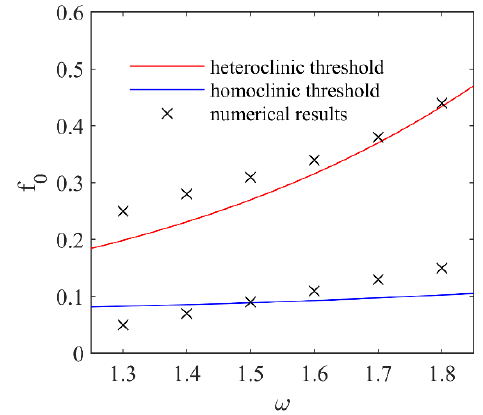
and f hetero of system (5) versus the excitation frequency ω . homo f and hetero f of system (5) versus the excitation frequency ω . Figure 9. f homo Figure 9. 0 0 0 0 As f 0 continues to increase, the variation of the dynamical behaviors and their basins of attraction can be observed in Figure 10. For f 0 = 0.37, the basins of attraction of the inter-well attractor are enlarged and intermingled with the intra-well one, as can be observed from the grey region and grey dots scattered in the green region of Figure 10(a2). That means that the occurrence probability of inter-well oscillation and inter-well jump between the two attractors increases, which is surely good for energy harvesting. When f 0 increases to 0.45, the fractality of basins of attraction becomes more obvious, and the basins of attraction of the intra-well attractor are seriously eroded by the basin of the inter-well attractor (see the intermingled green and brown regions in Figure 10(b2)). For f 0 = 0.52, there is very little basin of attraction of the intra-well attractor left, showing that the intra-well attractor becomes a rare attractor. As f 0 reaches 0.60, the whole initial-condition plane is brown, illustrating that the inter-well response becomes globally attractive, and favorable for the structure to harvest